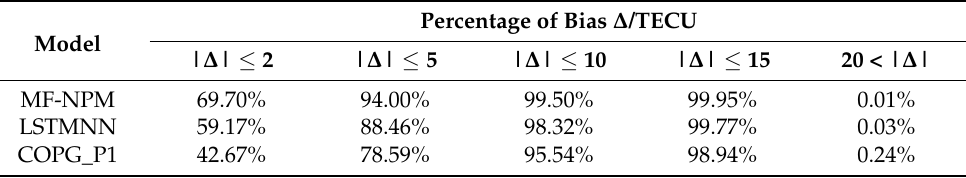
Figure 2. The variations of daily average ( a ) MTEC and ( b ) DMTEC predicted by MF-NPM, LSTMNN, and COPG_P1 relative to IGS in the peak year of solar activity (2014). and COPG_P1 relative to IGS in the peak year of solar activity (2014). Table 3. Percentage of bias for MF-NPM, LSTMNN, and COPG_P1 in the peak year of solar activity